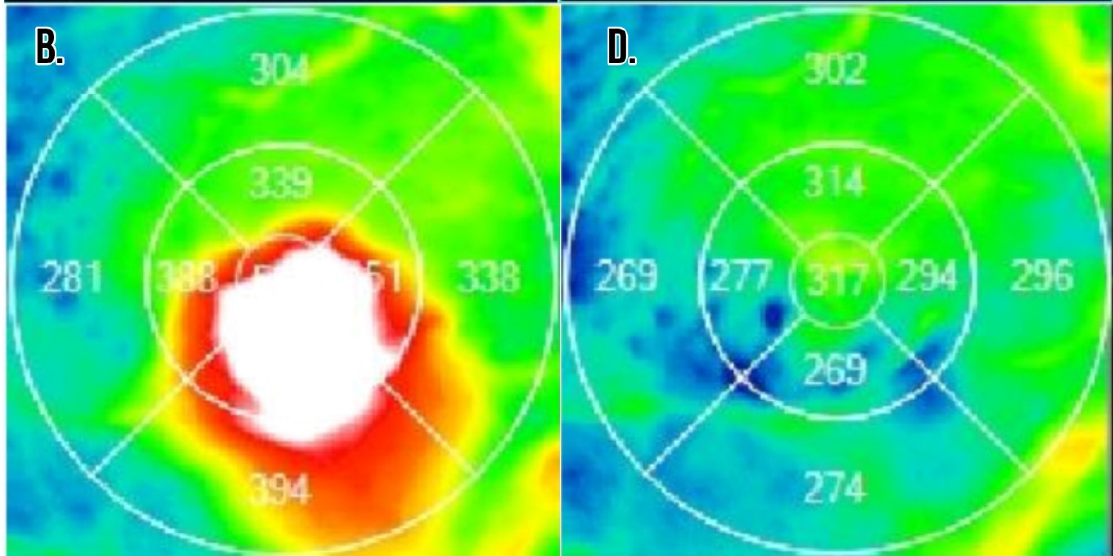
Figure 2. Example optical coherence tomography for a patient with branch retinal vein occlusion resistant to intravitreal anti-VEGF injections. ( A , B ) Macular cross-section and thickness map following multiple intravitreal anti-VEGF injections with visual acuity 20/80 and significant macular edema present. The decision was made to treat with a combination of intravitreal dexamethasone implant and anti-VEGF injection at this visit. ( C , D ) Macular cross-section and thickness map two months after the combination treatment with visual acuity now 20/20 and resolution of macular edema.